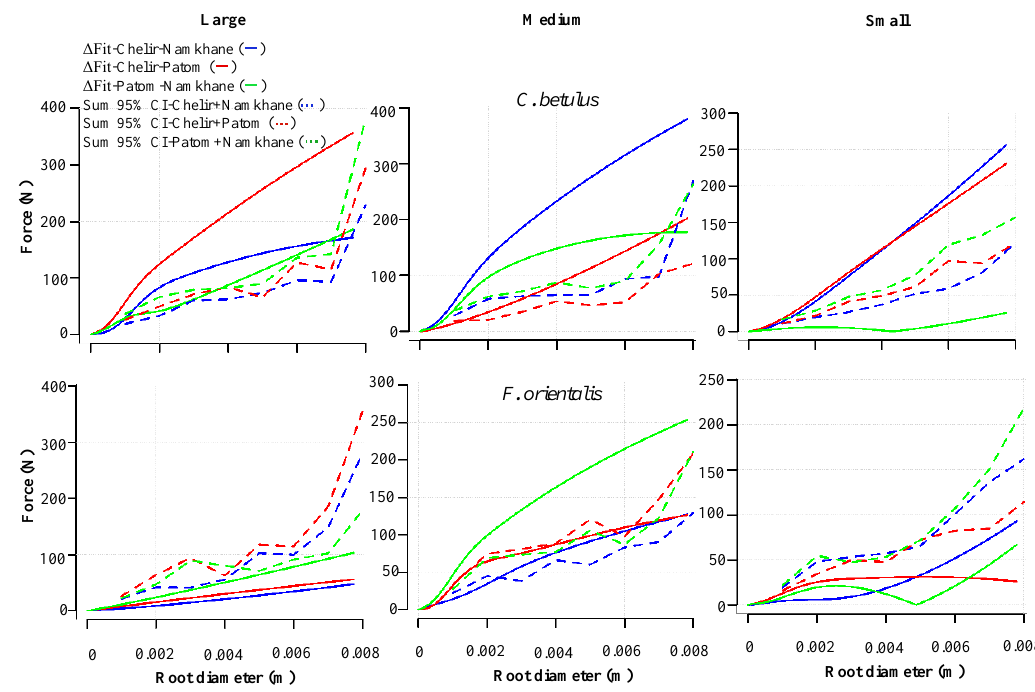
Figure 11. Calculation of difference between the fitting curves of tensile force vs. root diameter of three classes of diameter at breast height (DBH; small = 7.5–32.5 cm; medium = 32.6–57.5; and large = 57.6–82.5 cm) for Carpinus betulus and Fagus orientalis at three study sites (Chelir, Namkhane, Patom).